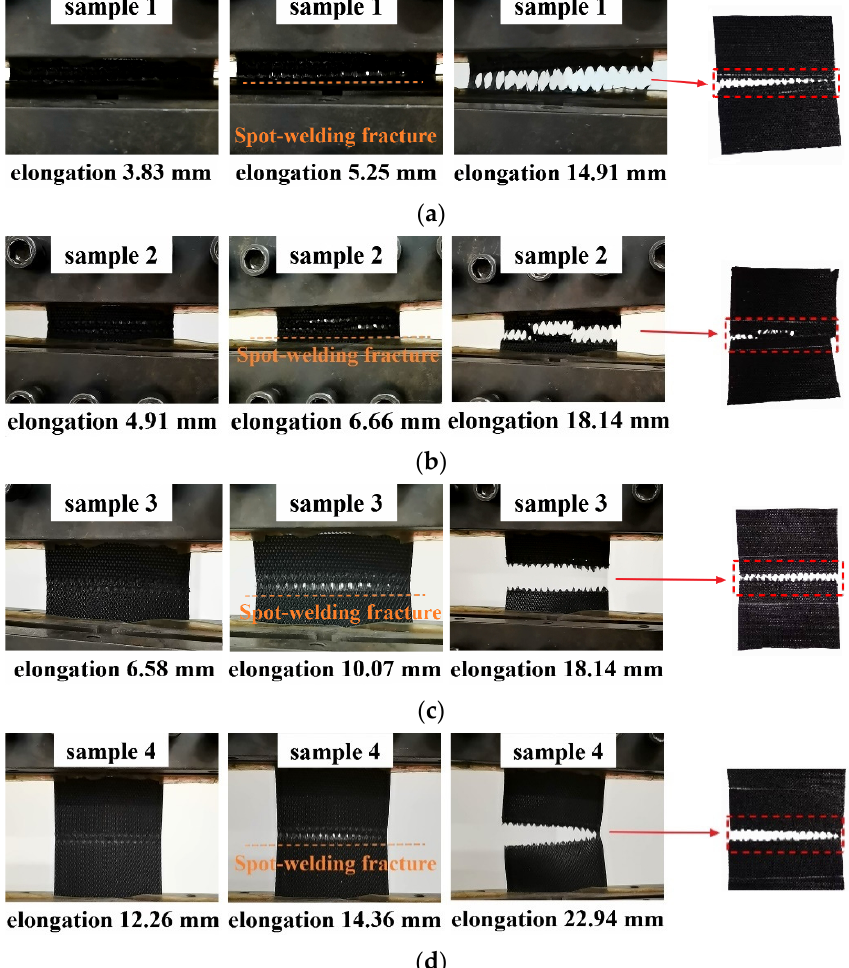
Figure 10. Failure modes of the junction subjected to uniaxial tension under various clamping distances: ( a ) 10.5 mm, ( b ) 25 mm, ( c ) 50 mm, ( d ) 100 mm.